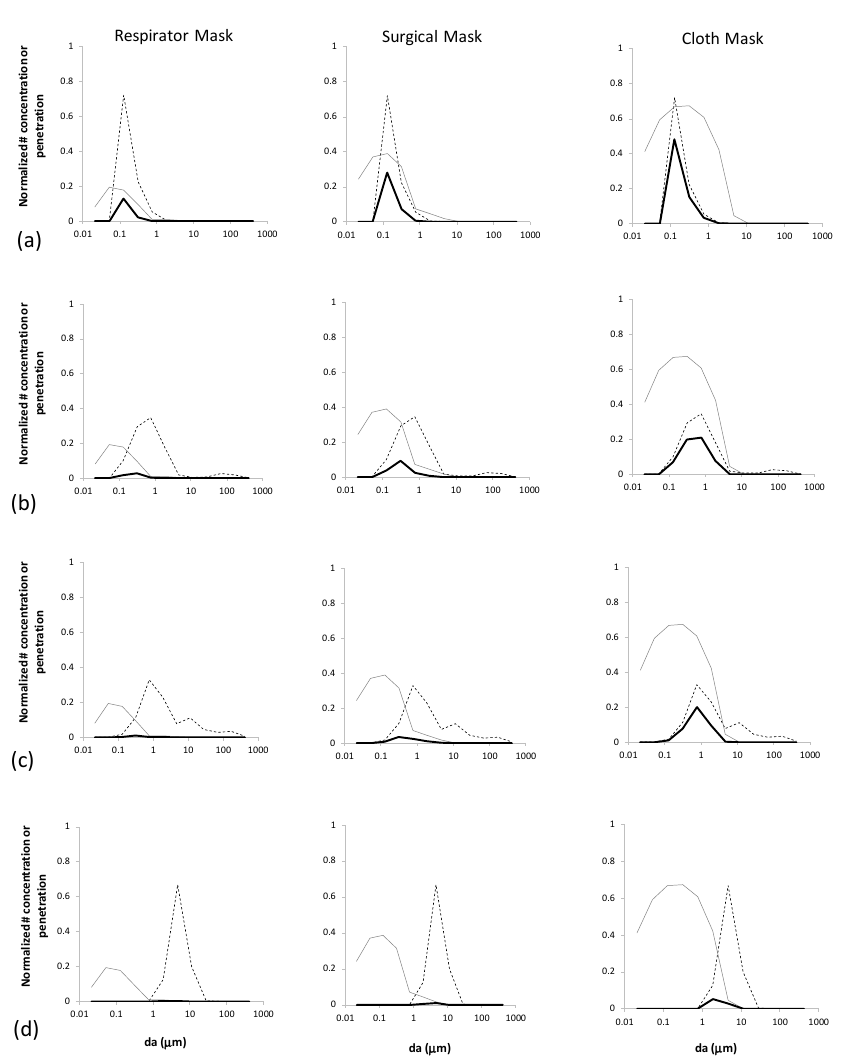
Figure 2. Comparison between mask penetration curves ( P ( d a ), gray) and normalized size distributions in the breathing zone ([ N bz (d a )/N bztot ]/ dlogd a ), dashed) and lower lung ([ N inh (d a )/N bztot ]/ dlogd a ), solid) for three modeled mask types and: ( a ) breathing-emitted SARS-CoV-2; ( b ) speaking-emitted SARS-CoV-2; ( c ) coughing-emitted SARS-CoV-2; and ( d ) wildfire ash.